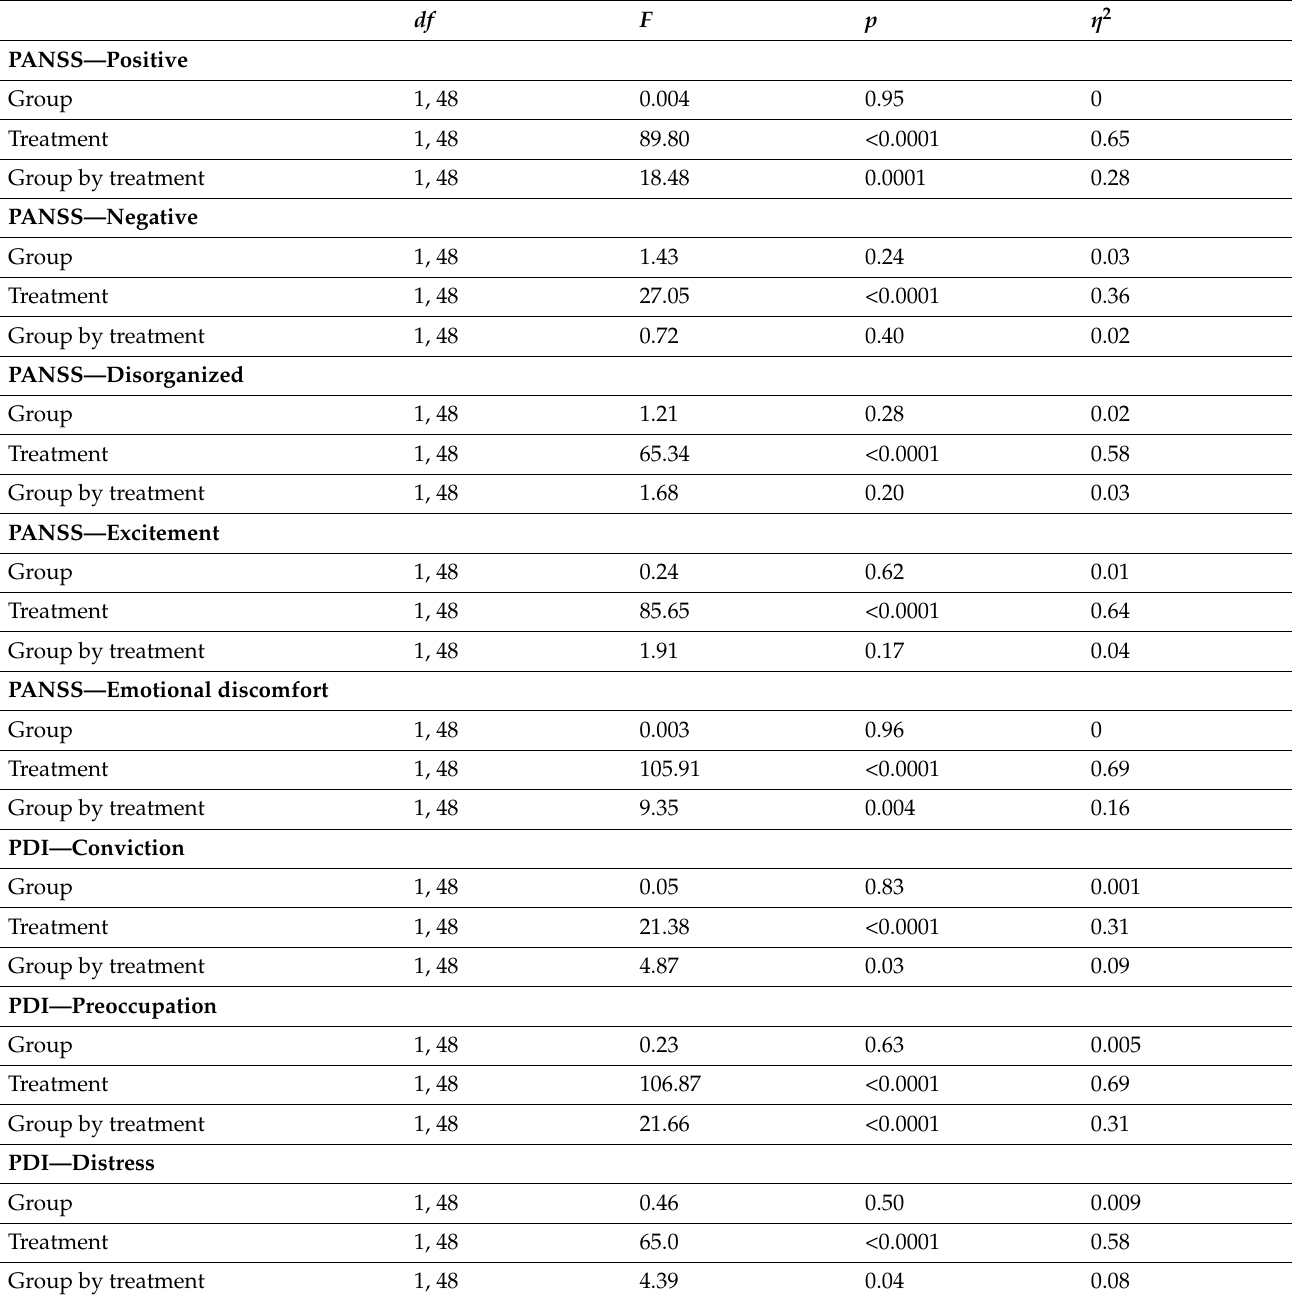
Table 5. Summary of ANOVAs conducted on the clinical scales in the schizophrenia groups treated with antipsychotics and antipsychotics plus